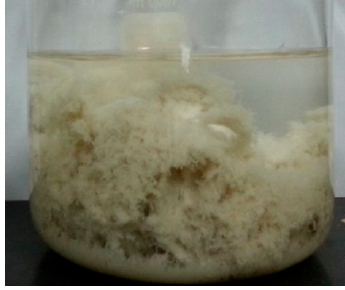
Figure 10. Flocculation of 4% bentonite suspension caused by addition of cationic polymer encapsulator.